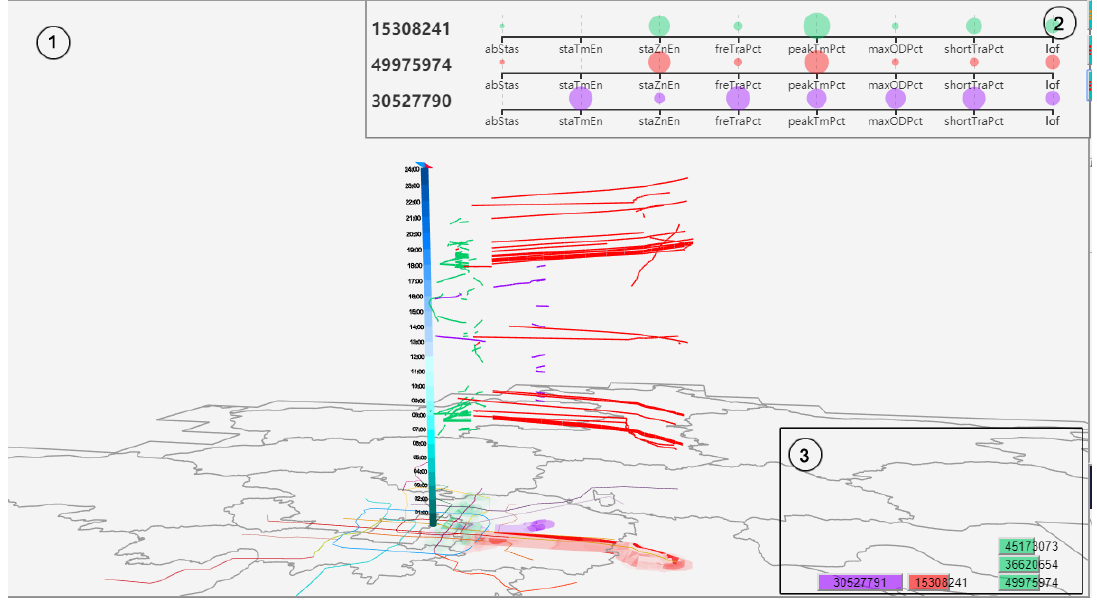
Figure 5. Passenger 3D travel trajectory view. (cid:172) : Passenger 3D Travel Trajectory View; (cid:173) : Travel feature view; (cid:174) : The relevance